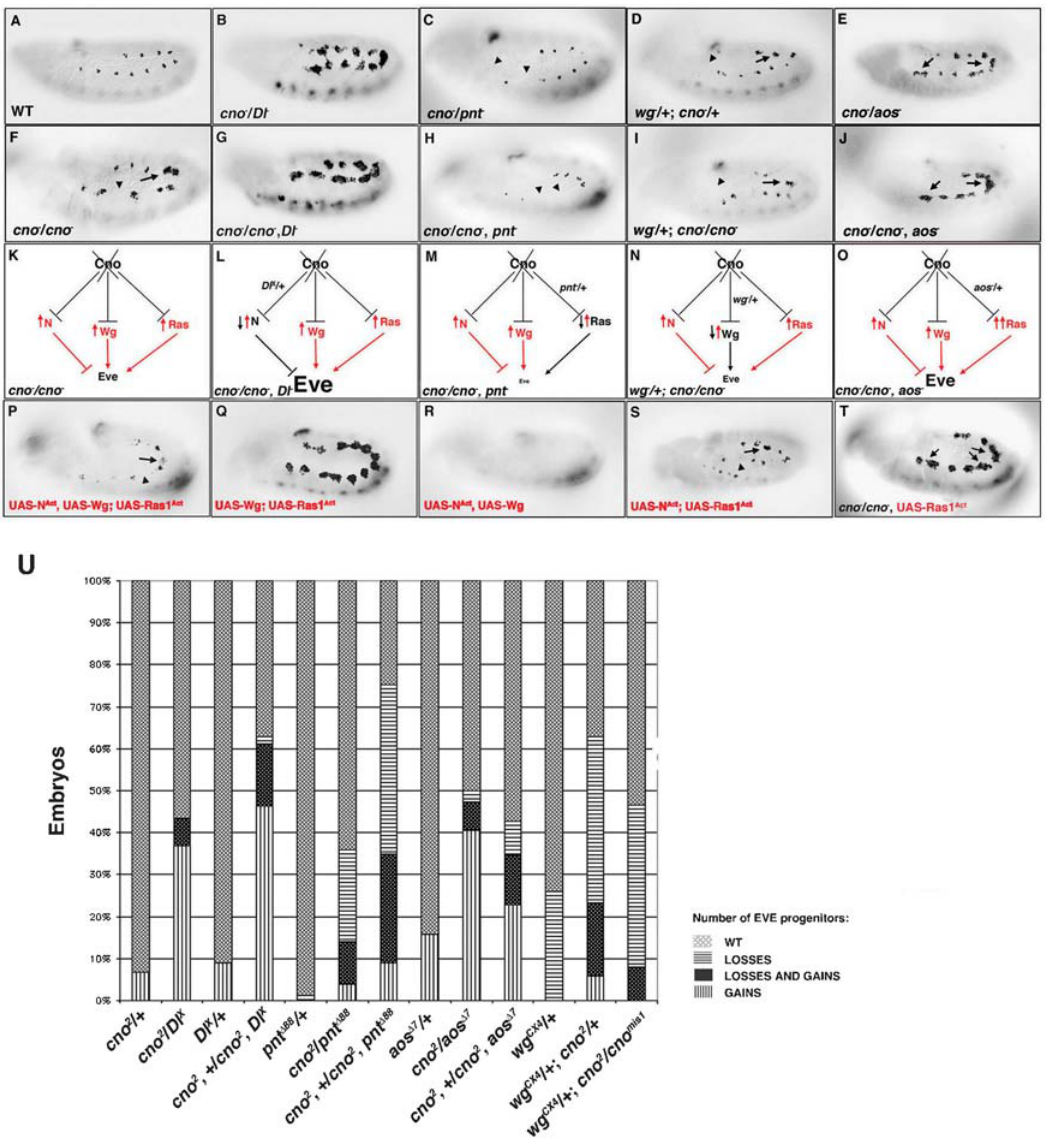
Figure 3. cno interacts genetically with N, Ras and Wg signaling pathways. (A–J and P–T) Lateral views of stage 11 embryos stained with an a -Eve antibody. (B, G) Extra Eve + progenitors are detected both in cno 2 /Dl X transheterozygotes and in cno 2 /cno 2 , Dl X embryos. (C, H) Both cno 2 /pnt D 88 double heterozygotes and cno 2 , pnt D 88 /cno 2 embryos show loss of Eve + progenitors. (E, J) An increase in Eve + progenitors is observed both in cno 2 / aos D 7 transheterozygotes and in cno 2 , aos D 7 / cno 2 embryos [74]. (D, I) Gain and loss of Eve + progenitors are detected both in wg CX4 / + ; cno 2 / + double heterozygotes and in wg CX4 / + ; cno mis1 /cno 2 embryos. (F–I, K–N, P–S): (P) Simultaneous mesodermal overexpression of N Act -Wg-Ras Act , (Q) Wg-Ras Act , (R) N Act -Wg and (S) N Act -Ras Act have similar phenotypes than cno 2 /cno 2 (F, K), cno 2 /cno 2 , Dl X (G, L), cno 2 /cno 2 , pnt D 88 (H, M) and wg CX4 / + ; cno mis1 /cno 2 (I, N) embryos, respectively. Arrows and arrowheads indicate gain and loss of progenitors, respectively. (K–O) Diagrammatic representation of the effect on Eve expression of cno lof (K) and cno lof in combination with reduced doses of N (L), Ras (M) and Wg (N) signaling components, or with increased doses of Ras signal (O). (T) The phenotype of Ras1 Act mesodermal overexpression is enhanced in a cno 2 mutant background. (U) Table shows % of embryos of the indicated genotype that display a wildtype number of Eve + progenitors, Eve + progenitors gain, loss and both (gain and loss). Legends for bars are shown right to the table. At least 70 embryos of each genotype were counted. P , 0.0001 for all genotypes except for cno 2 /cno 2 , aos D 7 (P=0.0239) and wg CX4 / + ; cno 2 / cno mis1